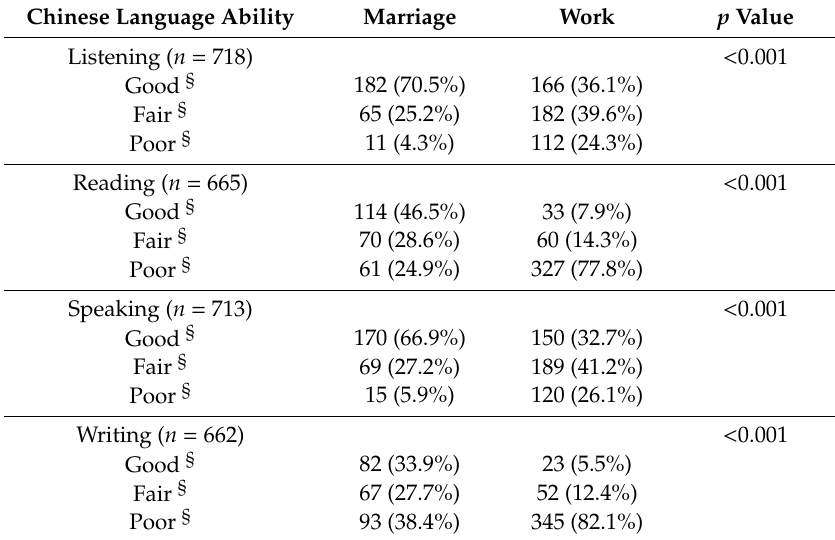
Table 2. Self-reported Chinese language abilities of the study population, stratified by reasons for migrating to Taiwan. Chinese Language Ability Marriage